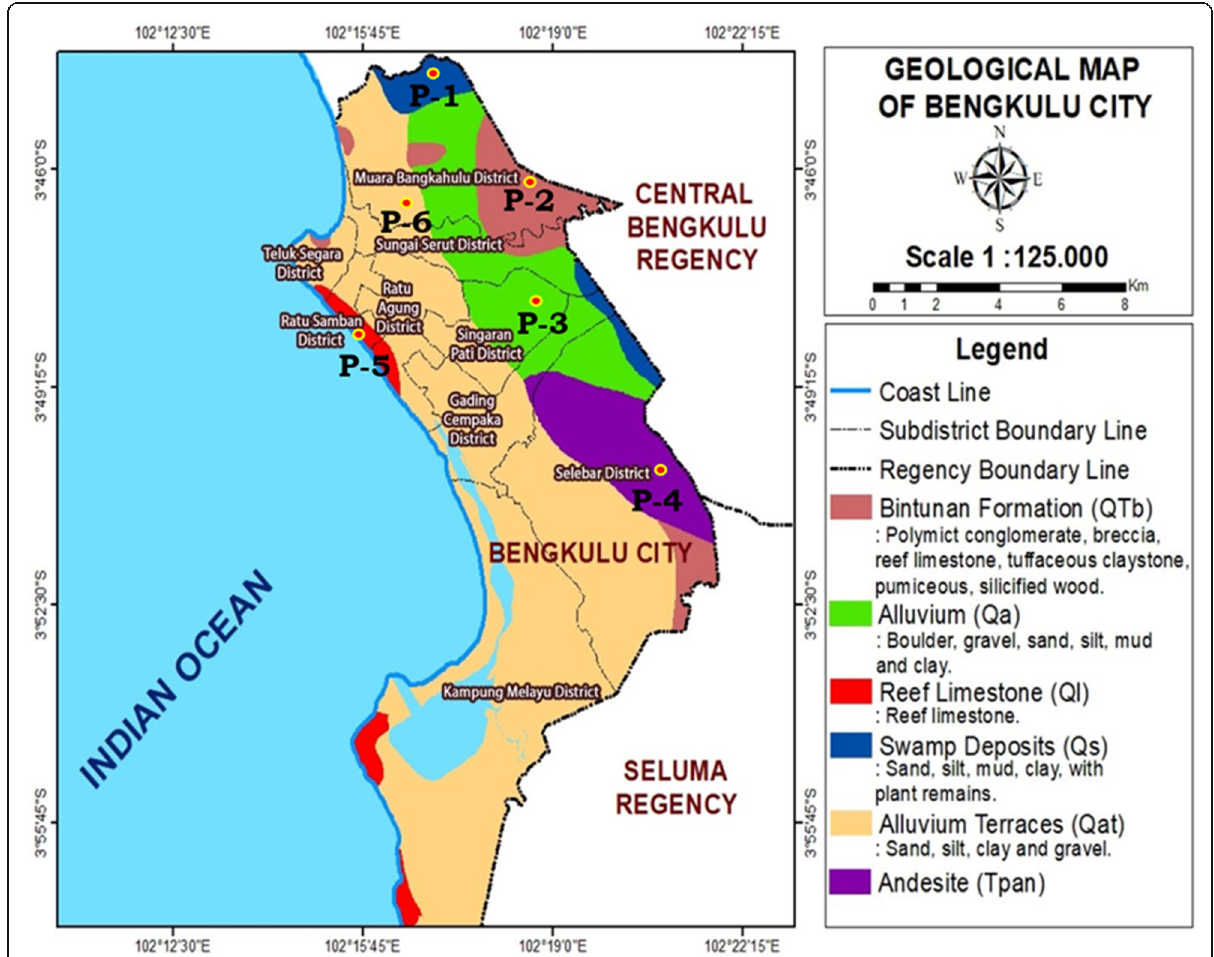
Fig. 2 Geologic map of Bengkulu City (modified from Natural Disaster Agency of Bengkulu Province,